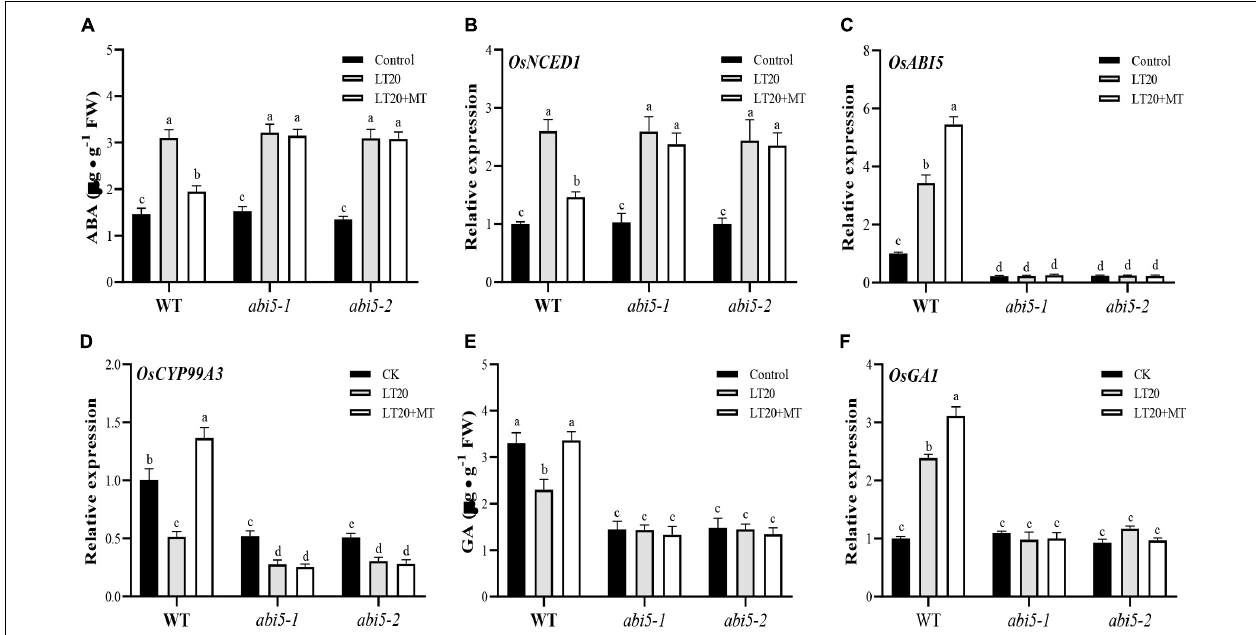
FIGURE 7 | Effects of exogenous MT treatment on the endogenous abscisic acid (ABA) and gibberellin (GA) biosynthesis under LT. (A) Endogenous ABA content, (B) transcript abundance of ABA biosynthesis gene ( OsNCED1 ), (C) ABA signaling gene [ABA INSENSITIVE 5 ( OsABI5 )], (D) ABA of catabolic gene ( OsCYP99A3 ), (E) endogenous GA content, and (F) transcript abundance of GA signaling genes ( OsGA1 ) under LT stress (constant 20 ◦ C for 7 days) without (LT20) or with (LT20 + MT) MT treatment in WT and the abi5 mutants. Different letters denote significant variations between the treatments, and the average values were measured by Tukey’s HSD test at p < 0.05. Data were represented as mean ± SE of six biological